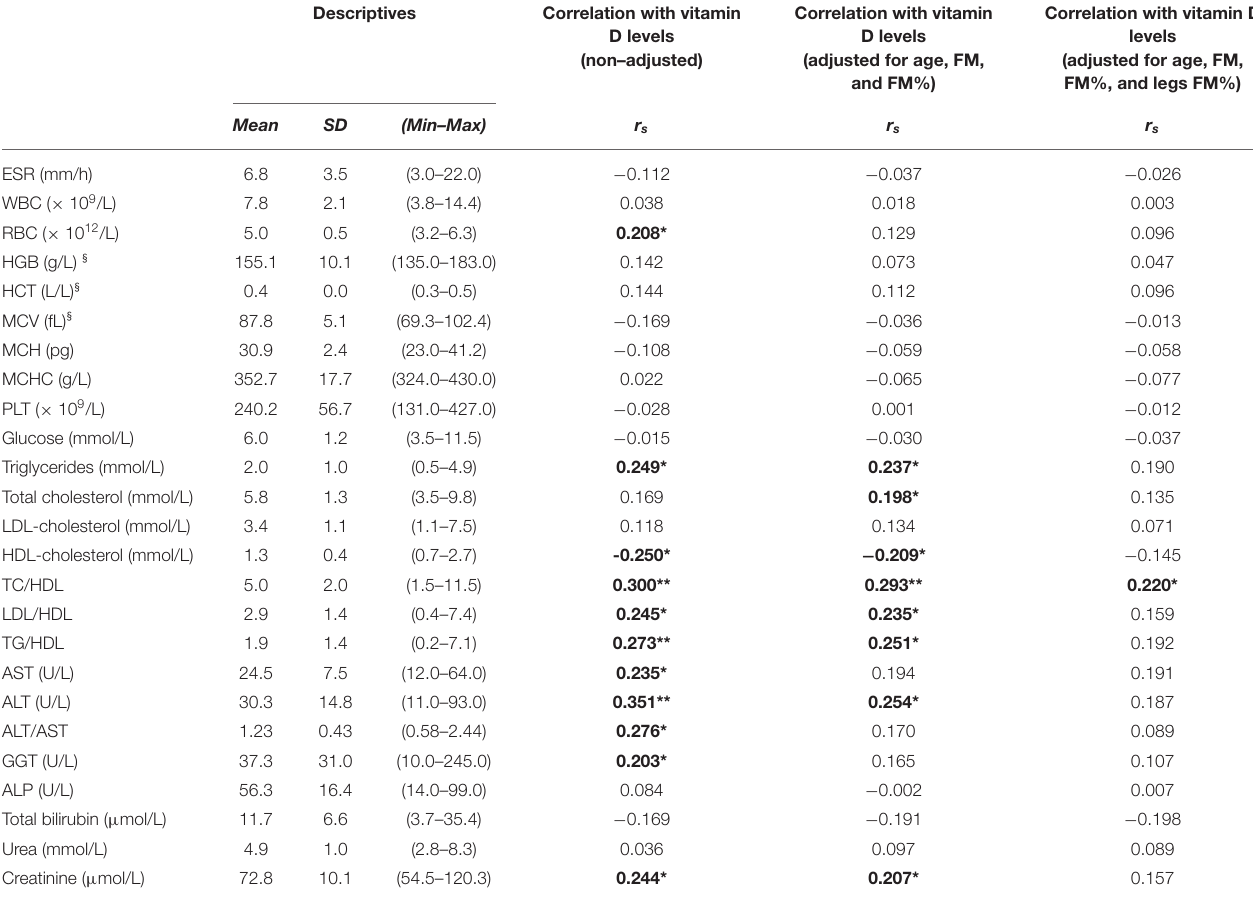
Descriptives Correlation with vitamin